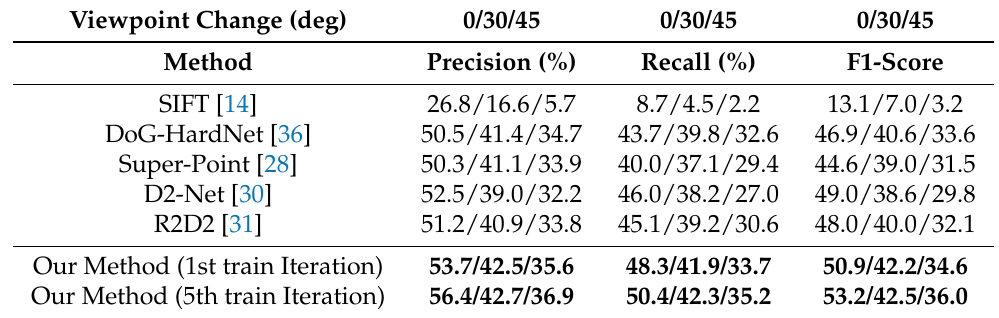
Table 4. RGB-IR image pairs matching results using 2K features. Precision (%), recall (%), and F1-score at different viewpoint change thresholds are